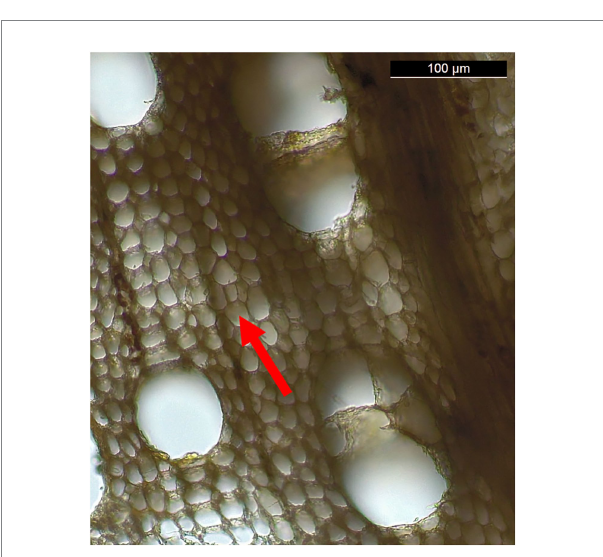
FIGURE 6 Detail of a thin section of Fagus cf. sylvatica . The arrow indicates a fiber with a thinned cell